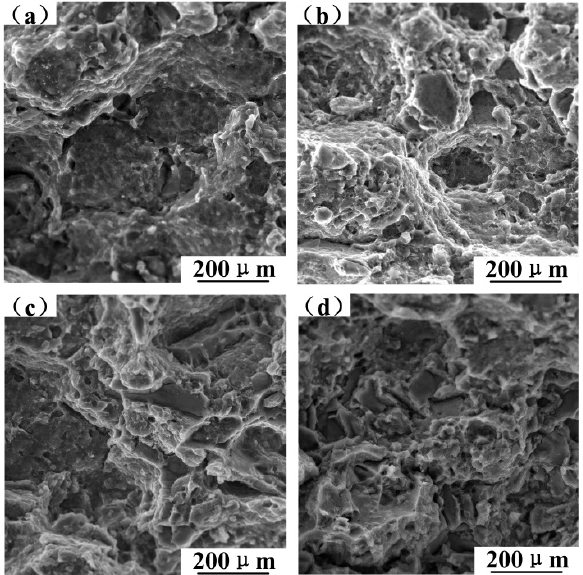
Figure 12. The fracture morphology in relation to SiC content after the room temperature tensile test: ( a ) T6-treated 5%SiC/6061, ( b ) T6-treated 10%SiC/6061, ( c ) T6-treated 15%SiC/6061, and ( d ) T6-treated 20%SiC/6061.